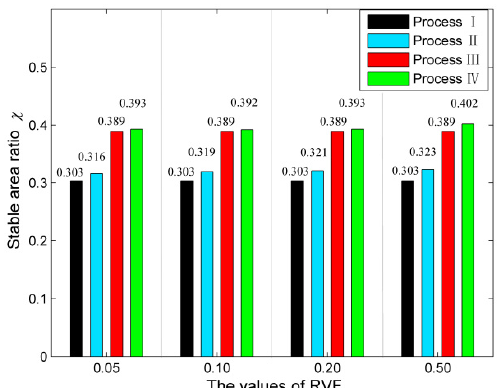
χ χ Figure 5. Comparisons of the values of associated with SLDs in Figure 4. Figure 5. Comparisons of the values of χ associated with SLDs in Figure Figure 5. Comparisons of the values of associated with SLDs in Figure 4.